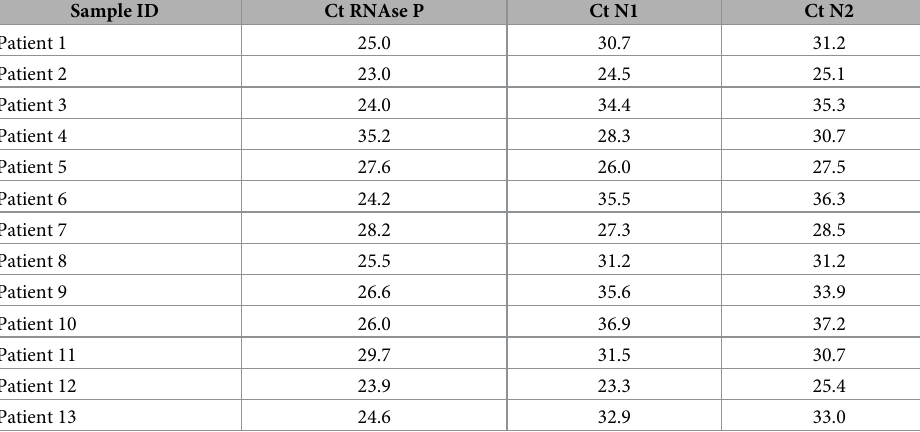
Table 4. RNAse P, N1 and N2 Cts in saliva samples of patients with